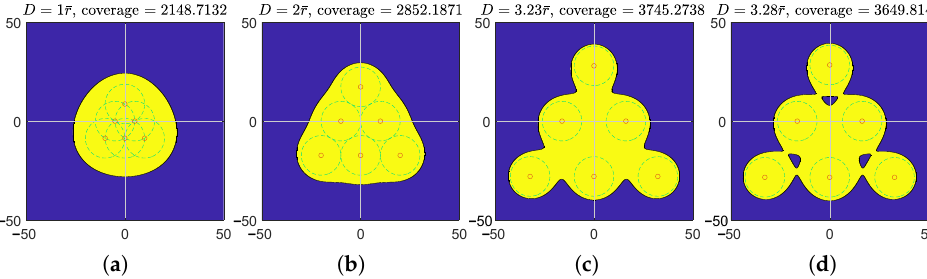
Figure 11. Illustration of effective coverages of n -node teams equipped with model I ( d ) = β / d 2 , where n = 6. The teams are in equilateral triangle formations. ¯ r = 10. ( a ) D = ¯ r ; ( b ) D = 2¯ r , individual effective coverage disks of adjacent nodes are tangent with each other; ( c ) the team’s effective coverage maximized; ( d ) the effective coverage at randomly picked separation while the region is still connected.